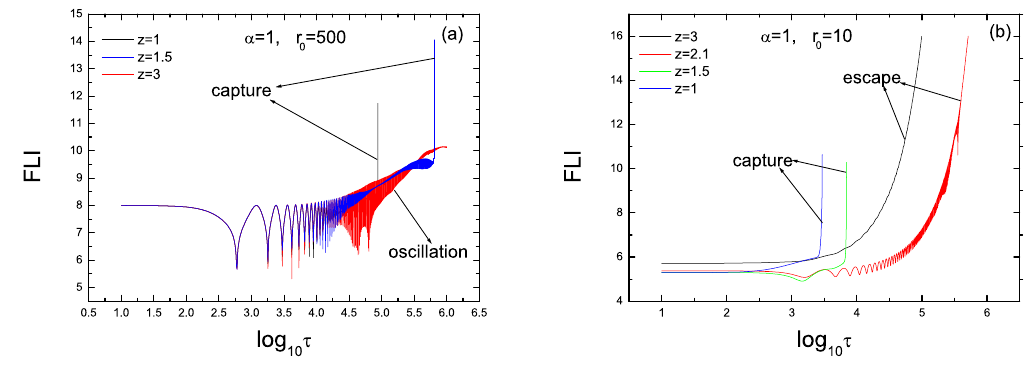
Figure 5 . FLIs for r 0 = 500 (left plot) and r 0 = 10 (right plot) with di(cid:11)erent z . Here, we set (cid:11) = 1 and T =